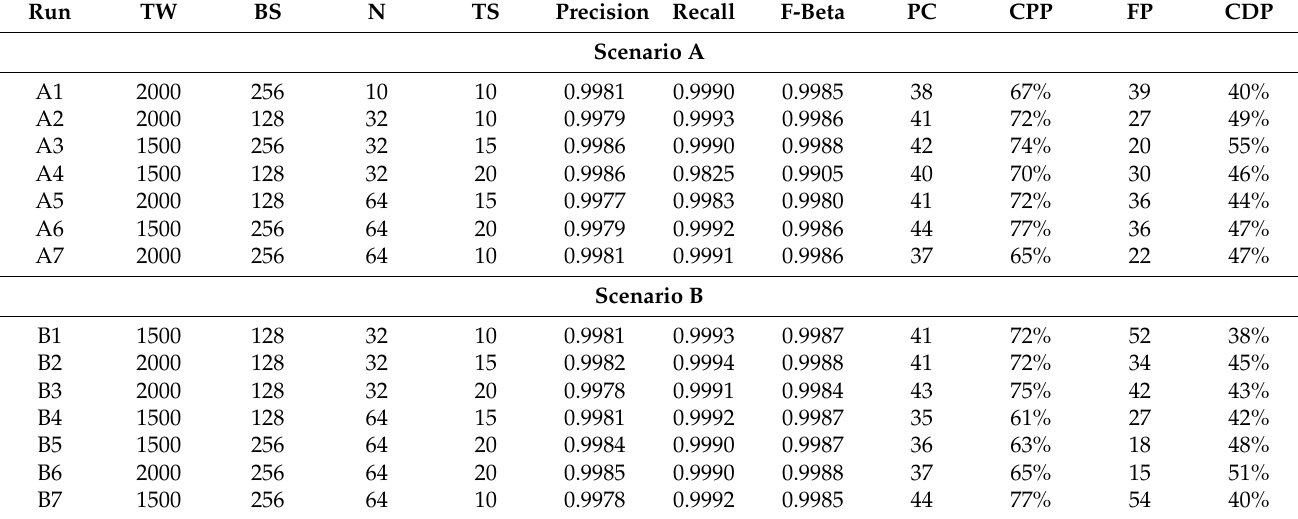
Table 3. One-Step Ahead Forecast Results, Part I. Legend: TW—Time Window; BS—Batch Size; N— Neurons; TS—Timesteps; PC—Predicted Collisions; CPP—Collision Prediction Percentage;